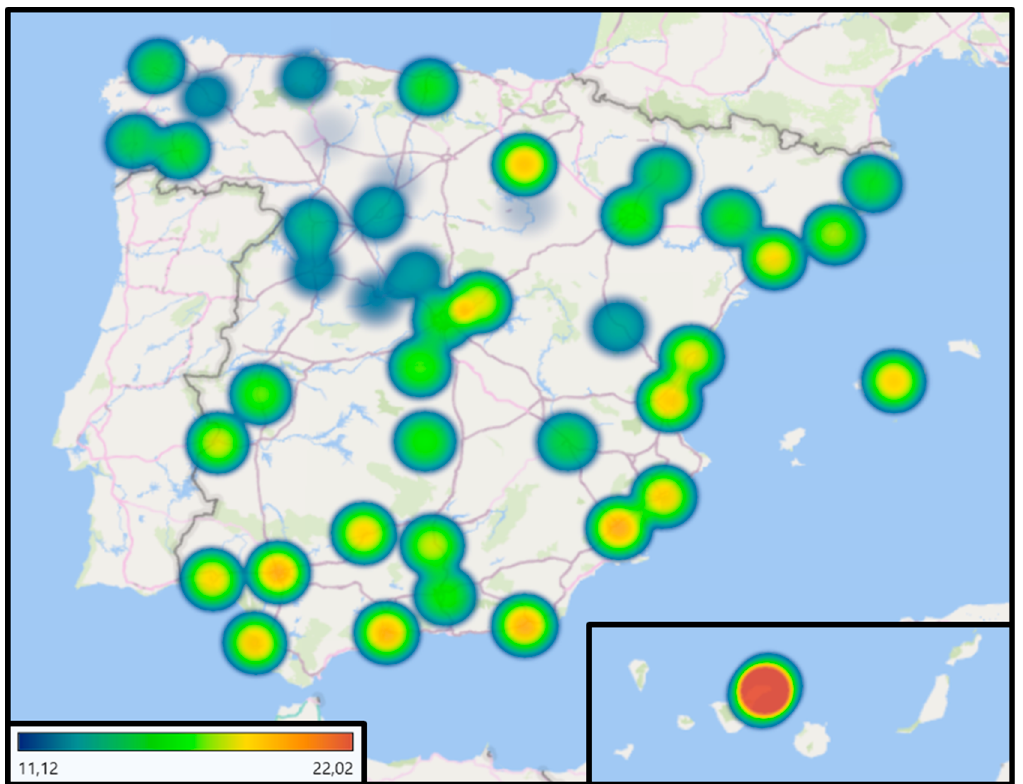
Figure 2. Average number of hours of sun per year and province (Own elaboration).